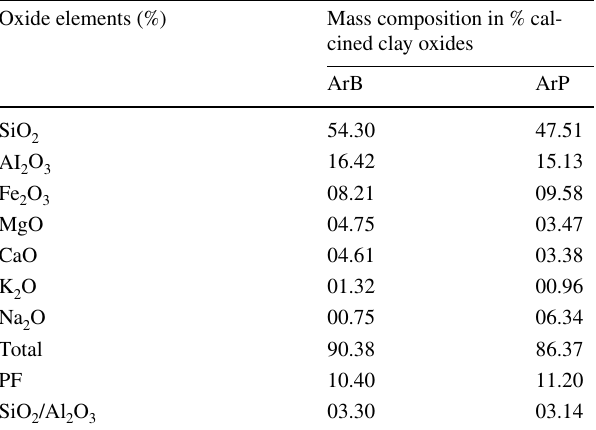
Table 1 Chemical composition of the catalyst Oxide elements